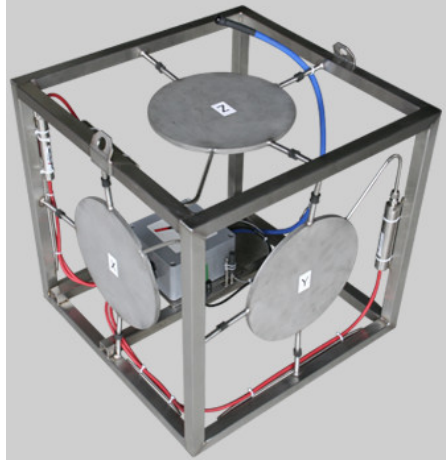
Figure 4. Earth pressure cell cage for measuring stresses in the SB slurry trench cutoff